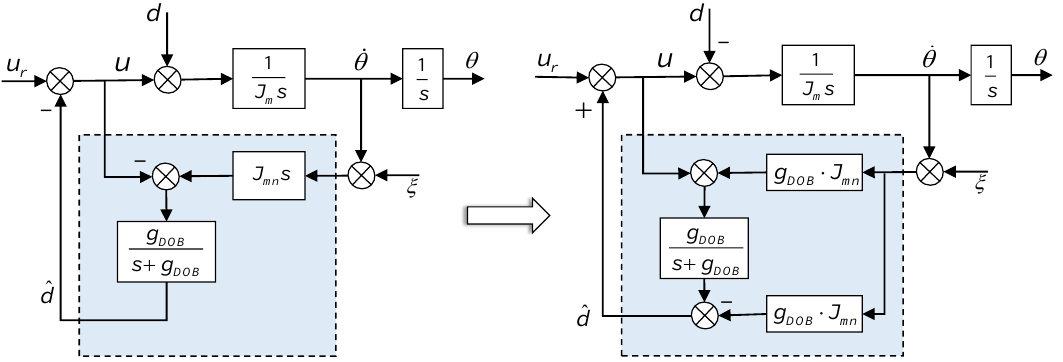
Figure 8. Motor-side model applied to disturbance observer.